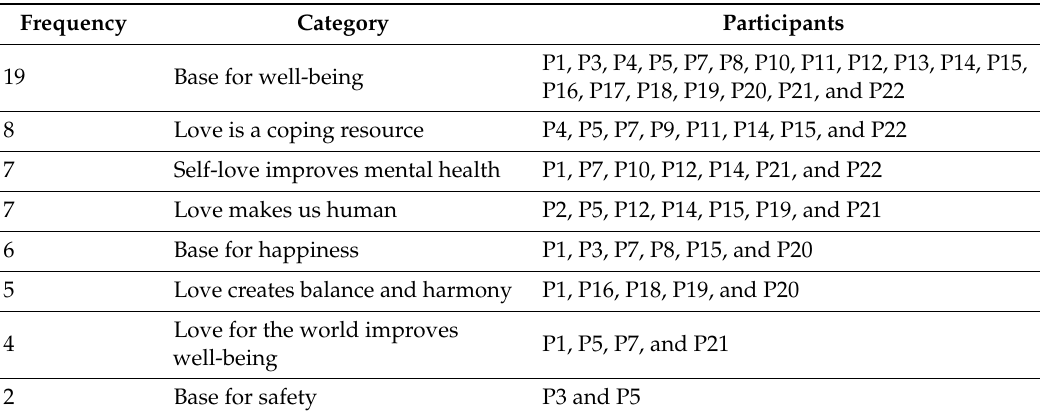
Table 1. Connection between love and mental